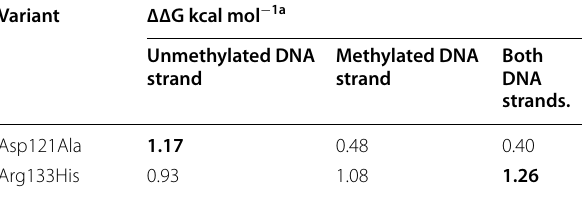
Table 5 ∆∆G of D121A and R133H